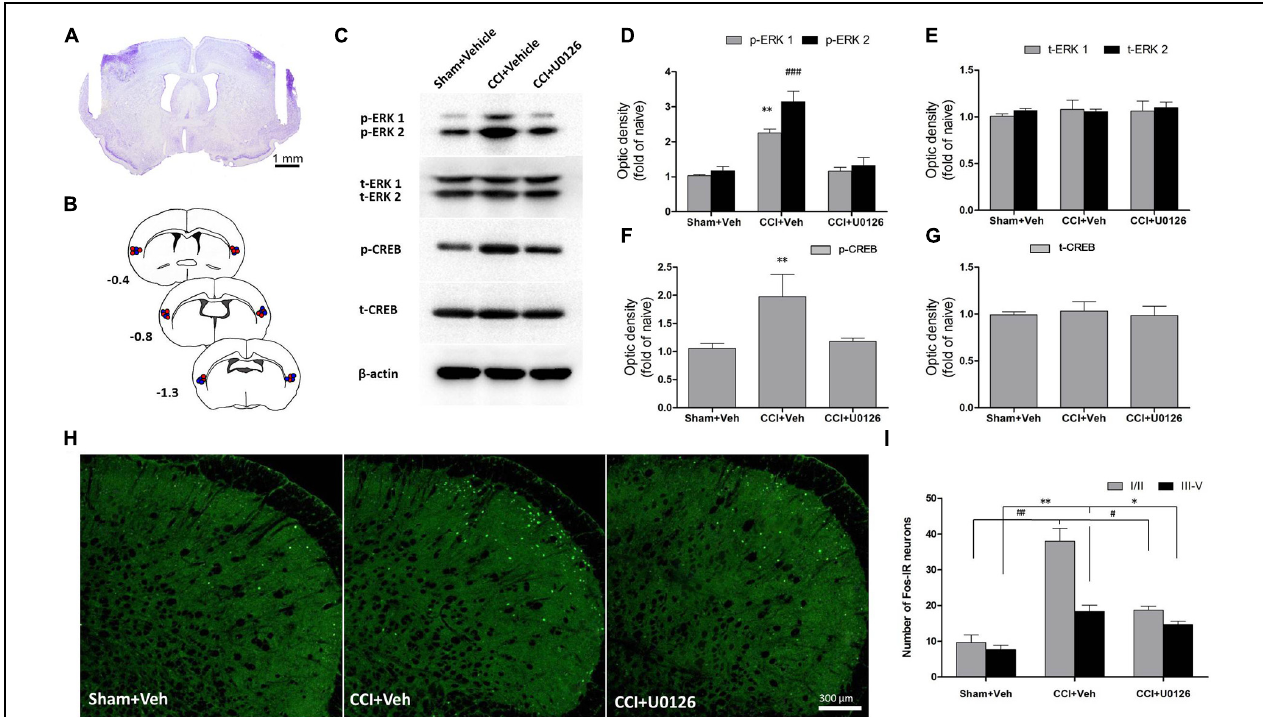
FIGURE 4 | Intra-IC U0126 microinjection reduced ERK pathway activity in the IC and decreased Fos expression in the Vc. (A) Representative Nissl-stained section showing injection sites within the IC. Scale bar = 1 mm. (B) Camera lucida drawings showing cannula tip placements in rats injected with U0126 (blue circles, n = 16) or vehicle (red circles, n = 16) in the IC. The numbers correspond to the distance in millimeters (mm) posterior to bregma in the brain. (C–G) Intra-IC U0126 infusion effectively inhibited ERK activation in IoN-CCI rats. In the absence of U0126, IoN-CCI produced a significant increase in the levels of phosphorylated ERK (p-ERK1/2) and CREB ( ∗∗ P < 0.01; ### P < 0.001 compared to the sham + vehicle group, n = 4). U0126 treatment remarkably decreased the upregulation of p-ERK (p-ERK1/2) and p-CREB expression in the IC of IoN-CCI rats. (H,I) Intra-IC U0126 administration partially reversed the elevated Fos expression in both laminae I/II and III-V of the Vc after IoN-CCI ( ∗∗ P < 0.01 ## P < 0.01 CCI + vehicle compared with the sham + vehicle group; ∗ P < 0.05 # P < 0.05 CCI + vehicle compared with the CCI + U0126 group; P < 0.05 CCI + U0126 compared with the sham + vehicle group, n = 4).